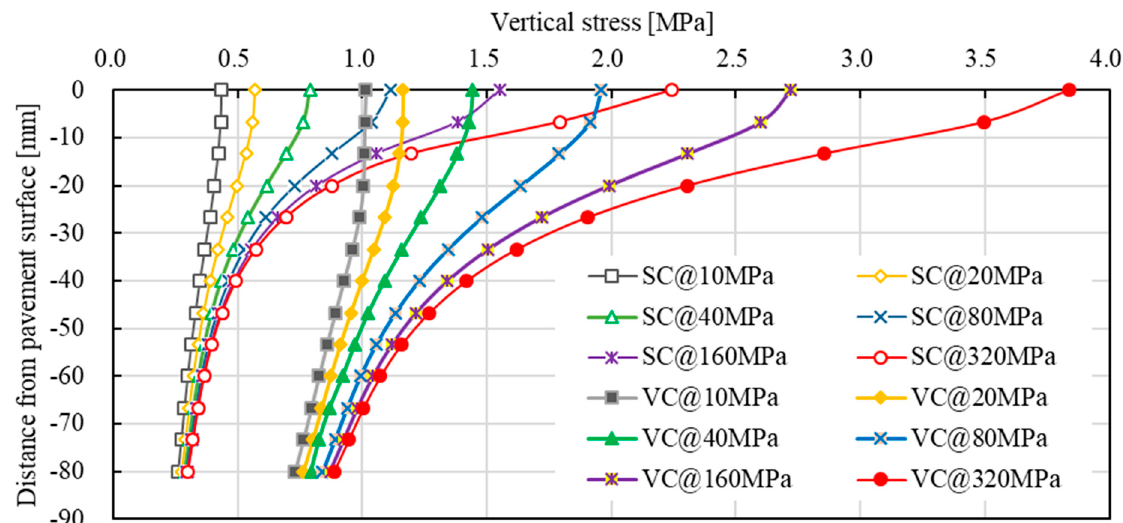
Figure 18. Effects of the asphalt mixture modulus on vertical stress distribution under static and vibratory roller compaction (SC: static compaction; VC: vibratory compaction; 10 MPa, 10 MPa, 20 MPa, 40 MPa, 80 MPa, 160 MPa, 320 MPa: asphalt mixture modulus).